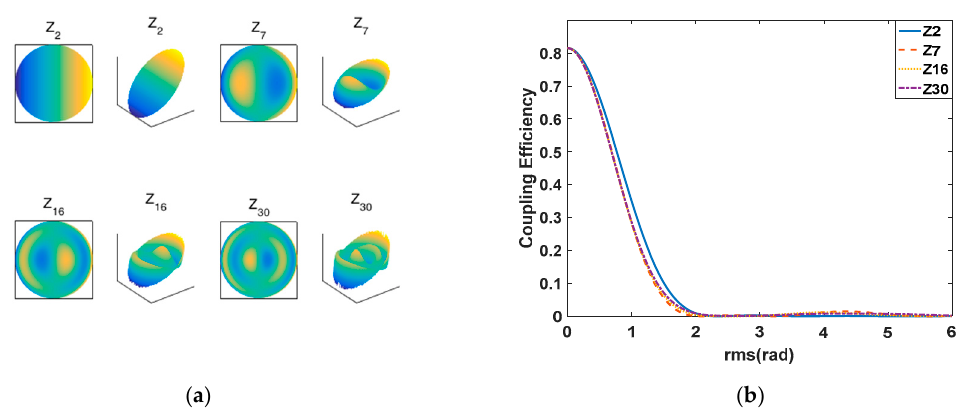
Figure 4. ( a ) Tilt-coma aberration patterns; ( b ) CE with tilt-coma item.